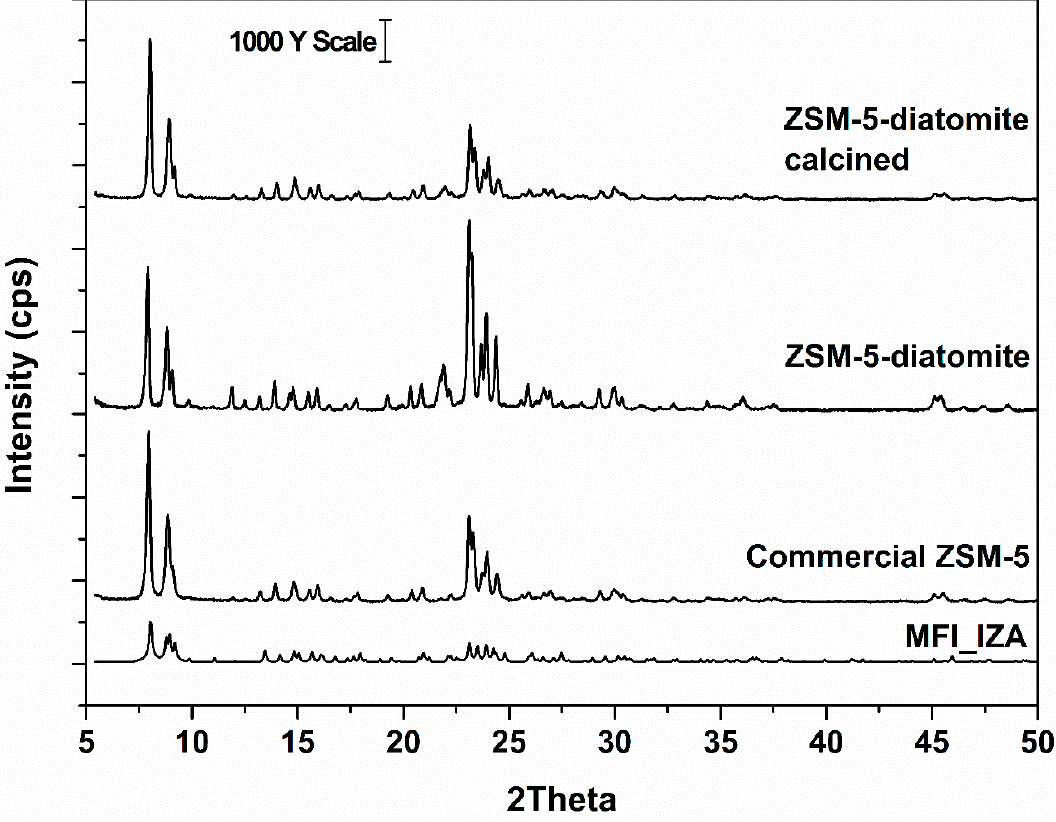
Figure 2. X-ray diffractograms of the zeolitic samples obtained with diatomite showing the success of obtaining MFI zeolitic topology. This result was maintained even after calcination.